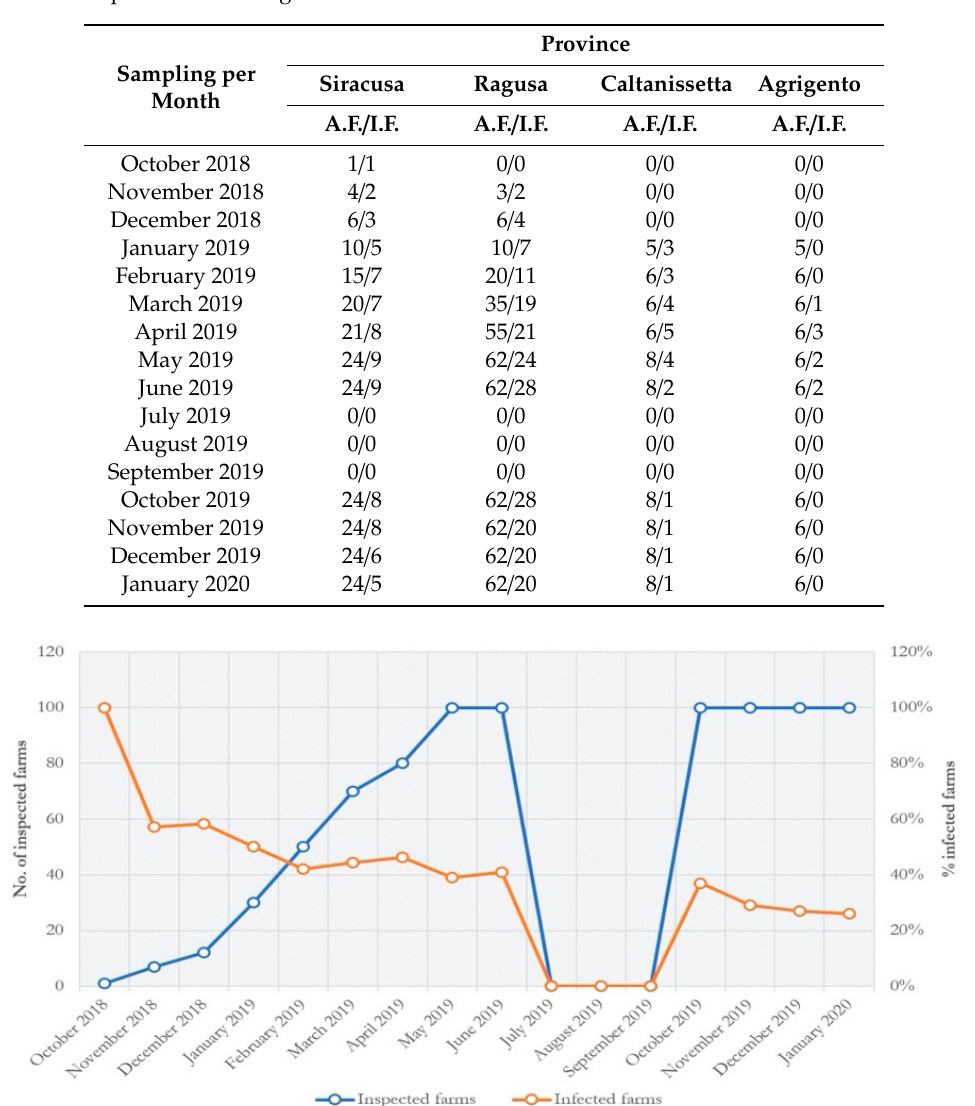
Figure 2. Number of lots of tomato plantlets analyzed per month, during the period November 2018– January 2020 and percentage of ToBRFV-infected lots.